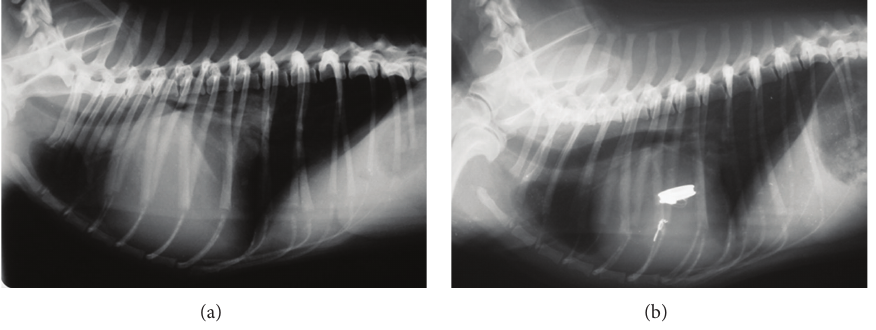
Figure 1: (a) Preoperative and (b) postoperative L-R X-ray photographs. Preoperative VHS 12.0 v decreased to 10.1v 3.5 months after opera- tion, and a mechanical valve is recognized in